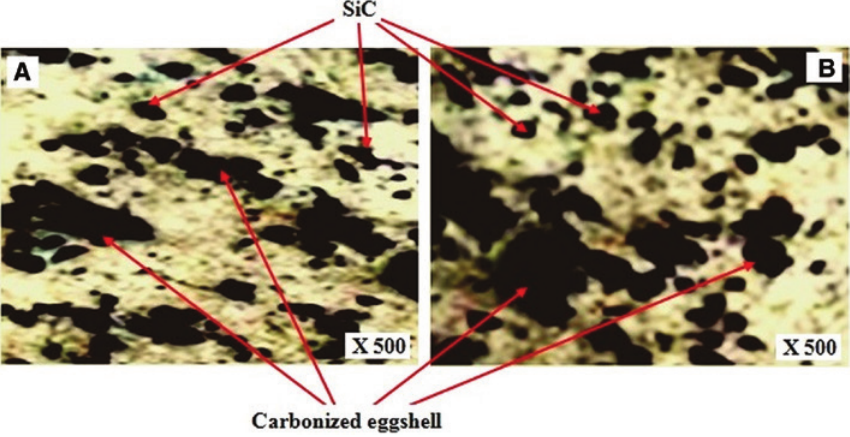
Figure 15: Microstructure of AA2014/6.5% carbonized eggshell/11% SiC hybrid green metal matrix composite.